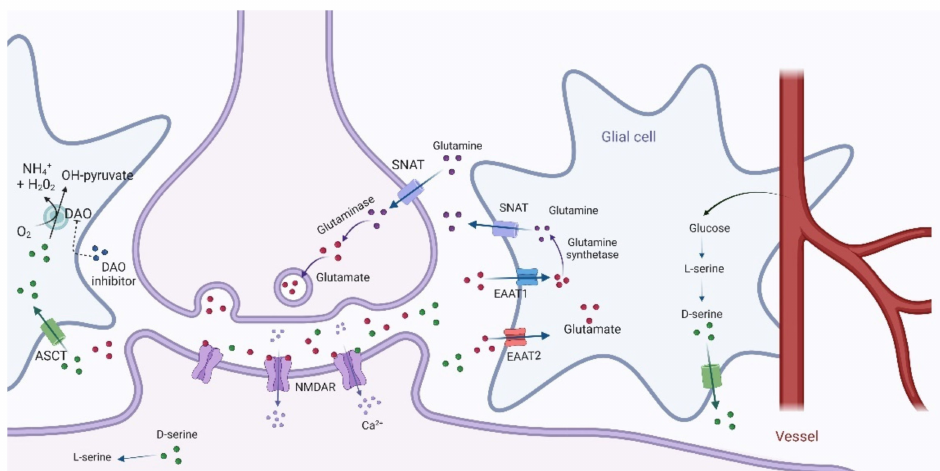
Figure 3. D-serine is synthesized in astrocytes by serine racemase, an enzyme that converts L-serine into D-serine. D-serine acts as a co-agonist at synaptic NMDARs, whereas its reuptake is performed by the neutral amino acid transporters Alanine-serine-cysteine-threonine (ASCT) 1 and 2. D-amino acid oxidase is responsible for D-serine degradation in glial cells. ASCT: Alanine-serine-cysteine-threonine transporter; EEAT1: Excitatory amino acid transporter 1; EEAT2: Excitatory amino acid transporter 2; SNAT: Sodium-coupled neutral amino acid transporter; NMDAR: N-Methyl-D-aspartate